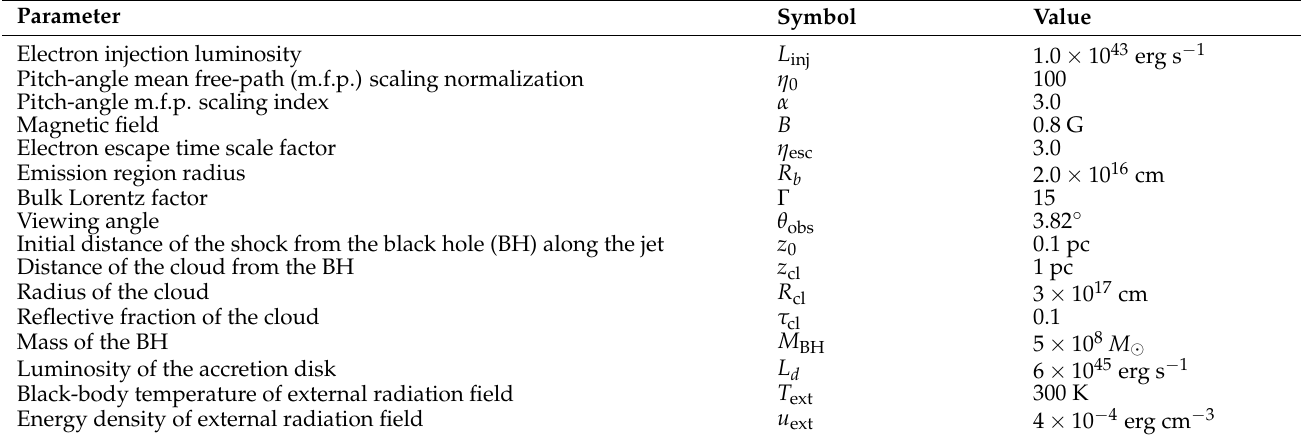
Table 1. Relevant model parameters for the case study motivated by the December 2013 flare of 3C279. Parameter Symbol Value Electron injection luminosity L